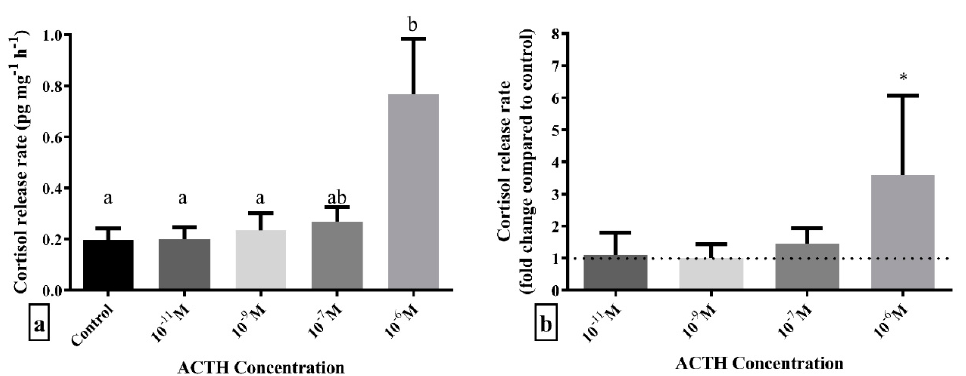
Figure 2. Cortisol release rate expressed as ( a ) pg cortisol per mg of scales per hour, pg mg − 1 h − 1 and ( b ) fold-change compared to control (dashed line) after 1 h in vitro incubation with different doses of ACTH. Results are expressed as average + SD (number of individuals in each trial n = 4, number of trials N = 3). Different letters indicate statistically significant differences between groups. Asterisks indicate statistically significant fold-change differences compared to control.